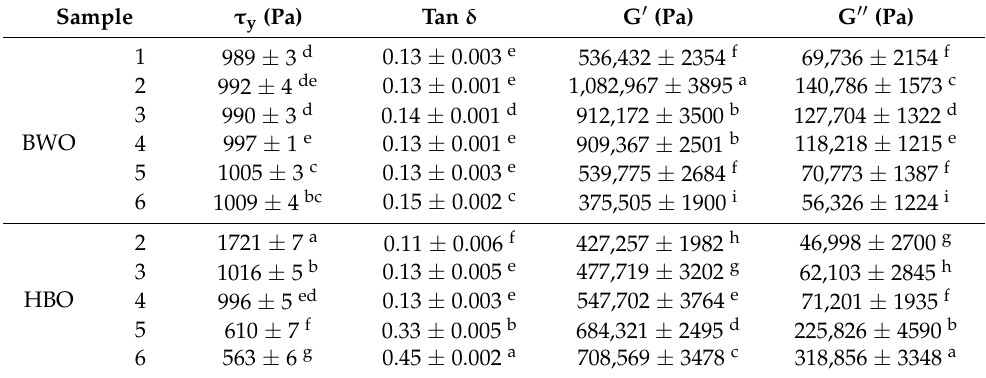
Table 3. Parameters related to strain sweep test of margarines prepared with BWO and